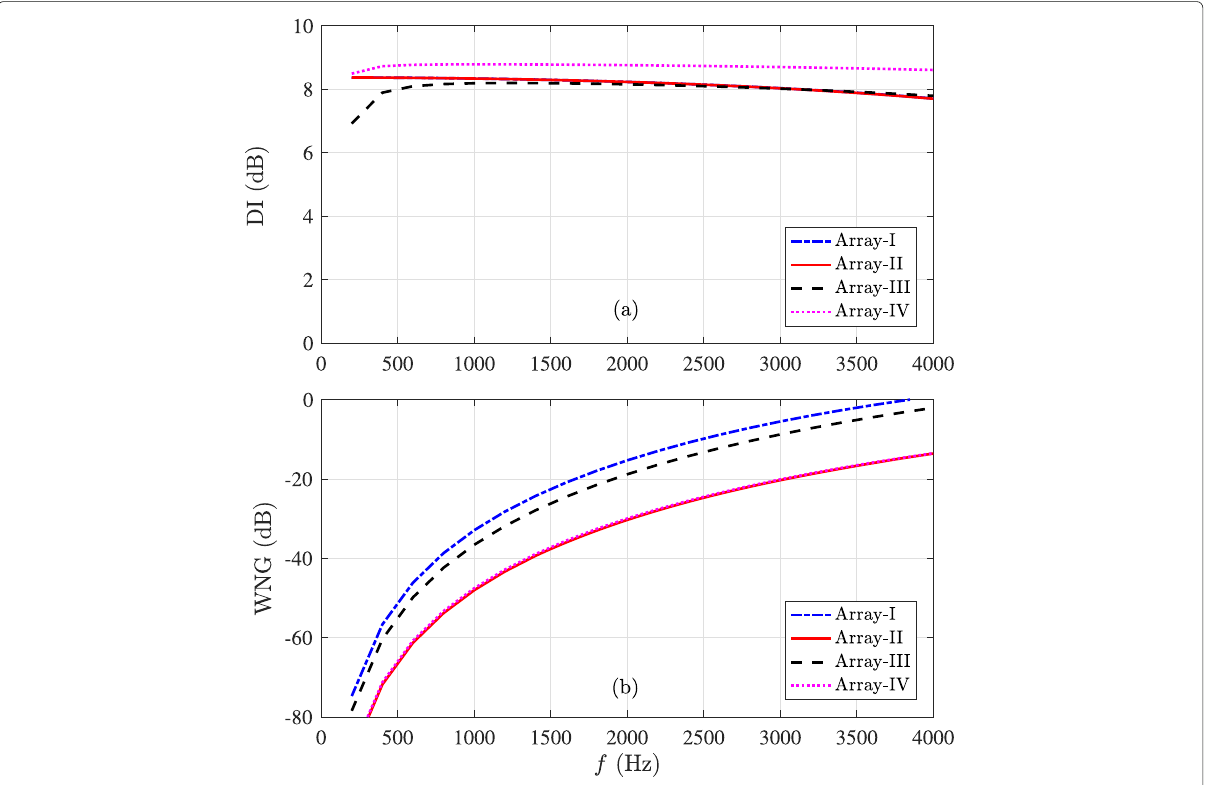
Fig. 9 DI and WNG of the third-order differential beamformer designed with four different array geometries: a DI and b WNG